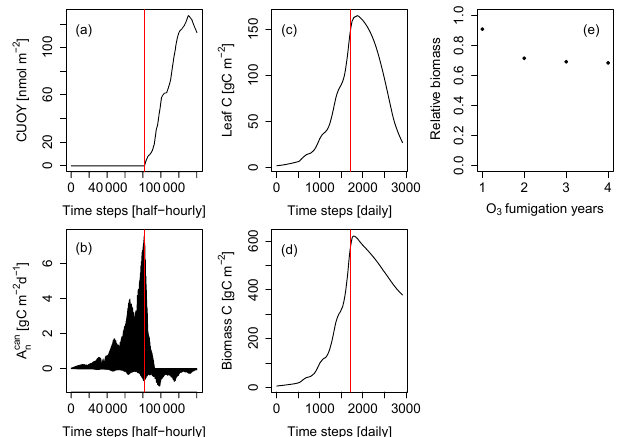
Figure 2. Simulated cumulative ozone uptake above a threshold of 0.8nmolm − 2 (leaf area)s − 1 (CUOY), canopy-integrated net pho- tosynthesis ( A can n ), leaf carbon content (Leaf C), total carbon in biomass (biomass C) and relative biomass (RB) of Pinus halepensis at the Ebro Delta fumigated with the NF+ ozone treatment. Simu- lations are conducted with the L12 PS model version. Panels (a-d) display the entire simulation period. The red line indicates the on- set of O 3 fumigation (NF+) in the fifth of eight simulations years. The relative biomass compared to a control simulation with zero O 3 concentration (e) is displayed for the O 3 fumigation years.